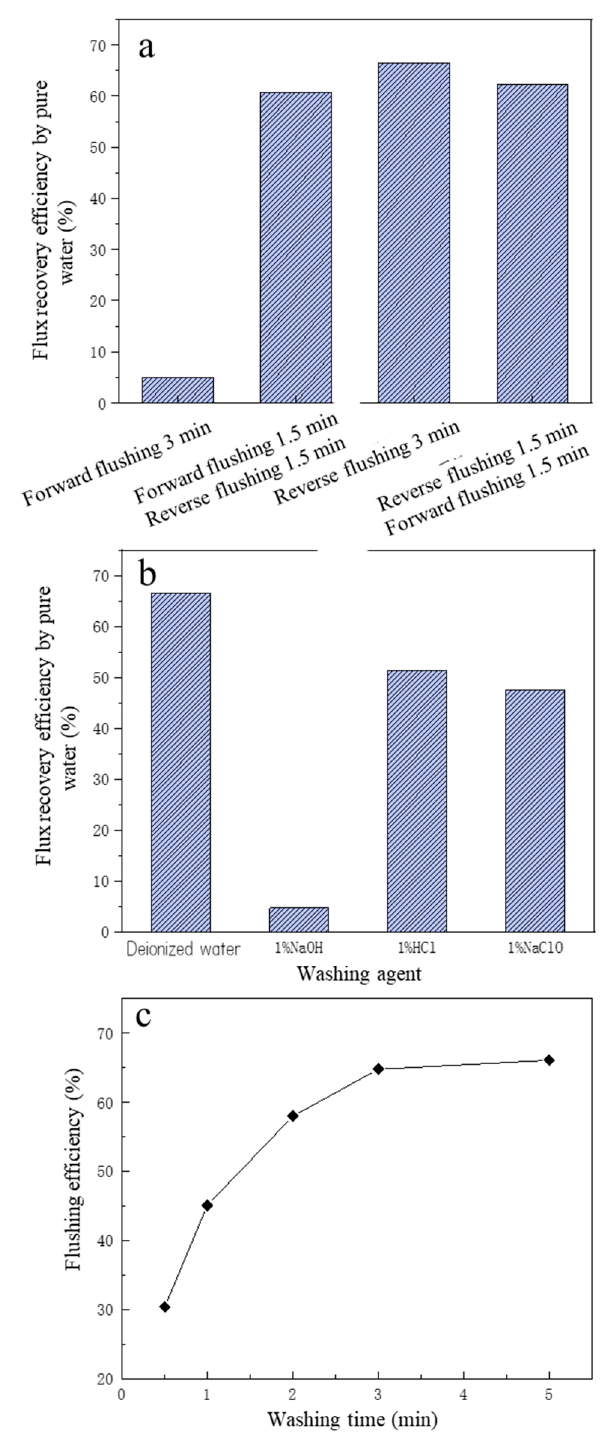
Figure 4. The effect of different flushing operations on flux recovery efficiency of microfiltration: ( a ) the flushing methods; ( b ) the flushing agents; ( c ) the effect of washing time on flushing efficiency .